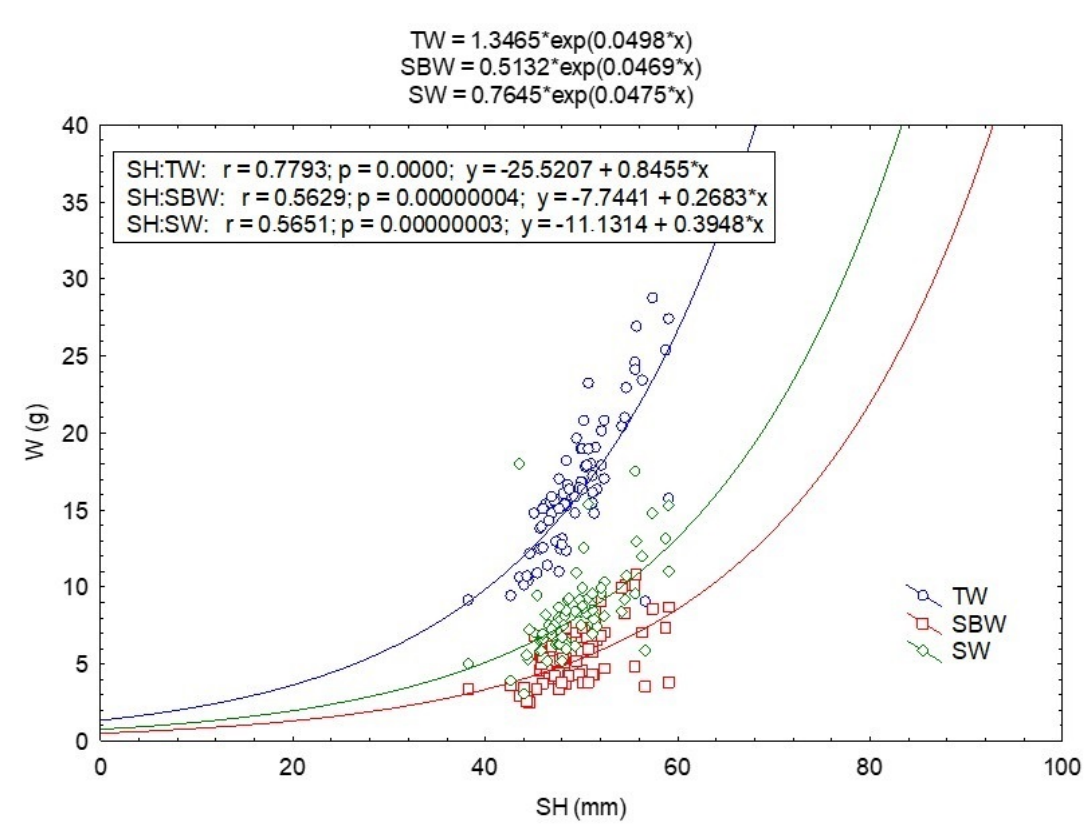
Figure 2. Relationship of total weight (TW), soft body wet weight (SBW) and shell weight (SW) to shell height (SH) of A. opercularis individuals.